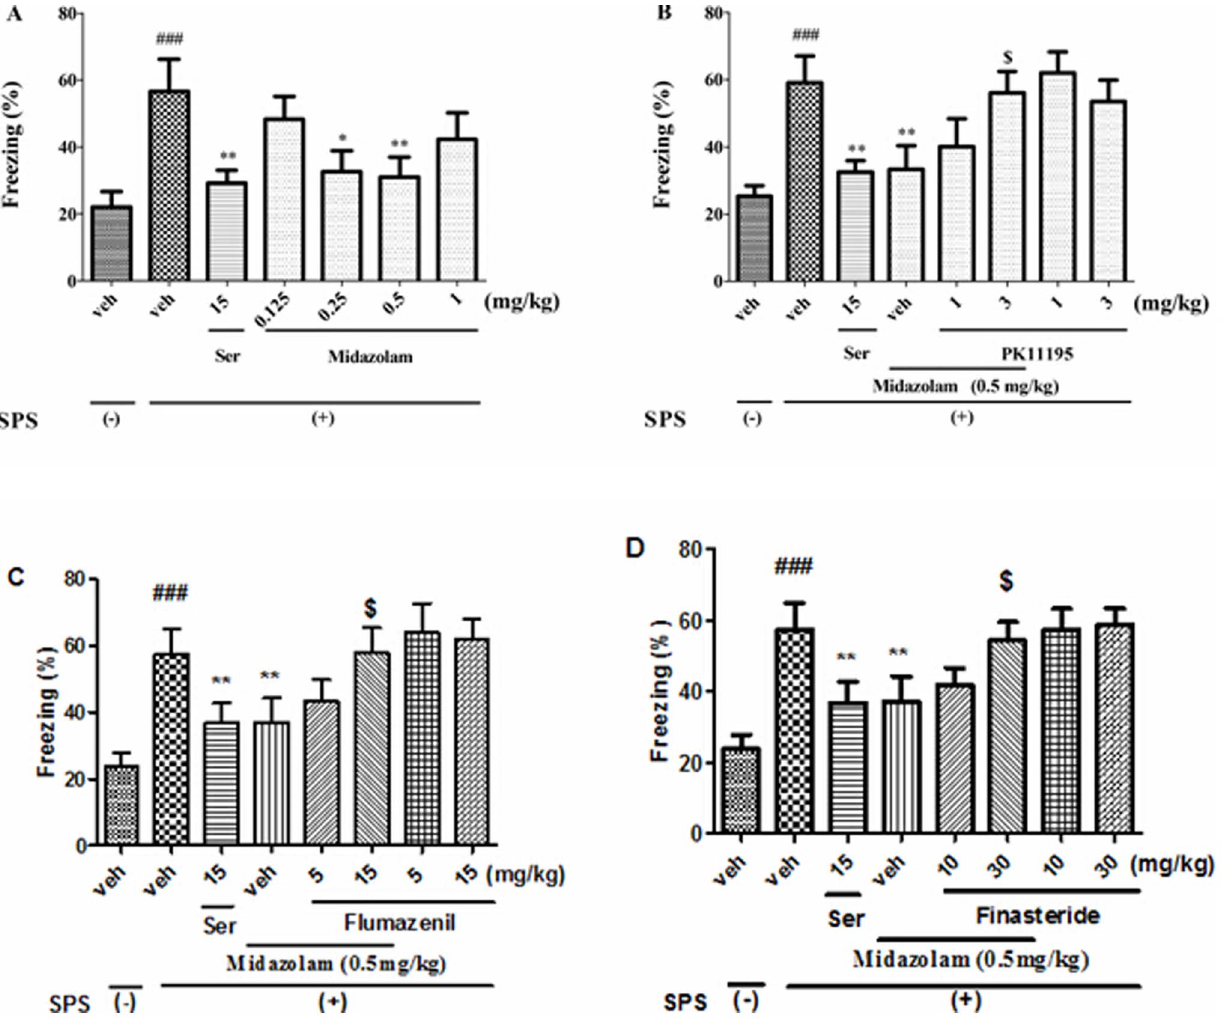
Figure 3. Effects of midazolam on the freezing behavior of rats subjected to SPS. The freezing time was reduced by midazolam (0.25 and 0.5 mg/kg, p.o.) (A), which was reversed by PK11195 (3 mg/kg, i.p.) (B), flumazenil (15 mg/kg, p.o.) (C), or finasteride (30 mg/kg, p.o.) (D). ### p , 0.001 vs. vehicle-treated SPS (-) group; * p , 0.05, ** p , 0.01 vs. vehicle-treated foot shock ( + ) group; $ p , 0.01 vs. midazolam-treated group (0.5 mg/kg, p.o.) (n=10).